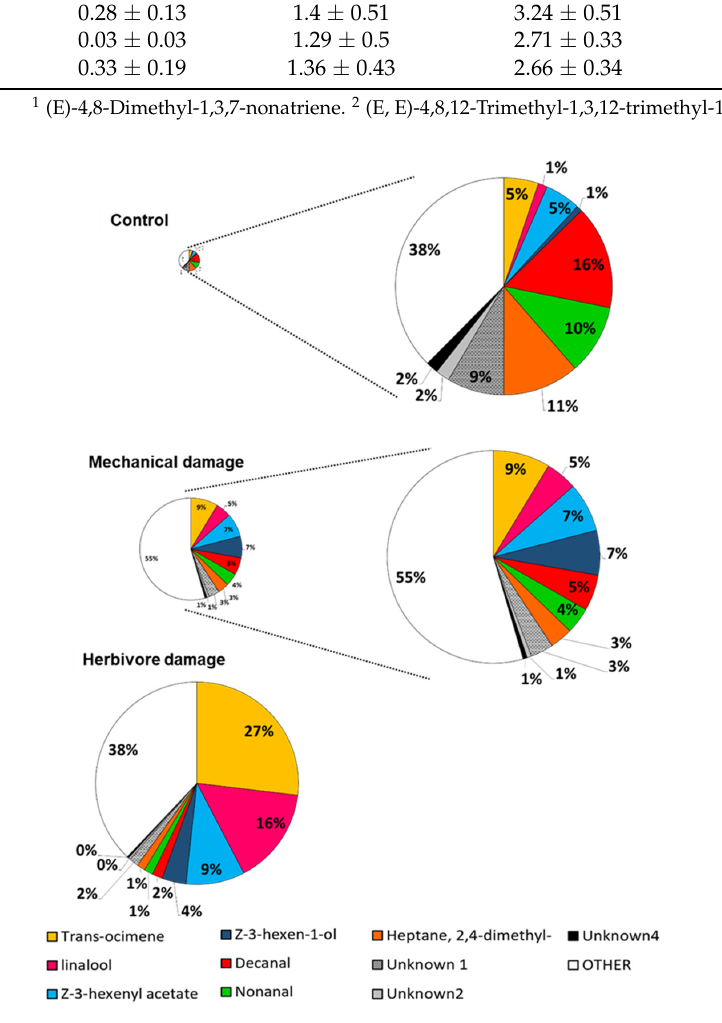
Figure 2. Relative proportions of VOC emissions of P. lunatus plants subjected to mechanical damage and herbivore damage by D. baleata , as well as undamaged controls. Only compounds with significant differences are depicted. Circle sizes are proportional to the average total volatile emissions of plants in each